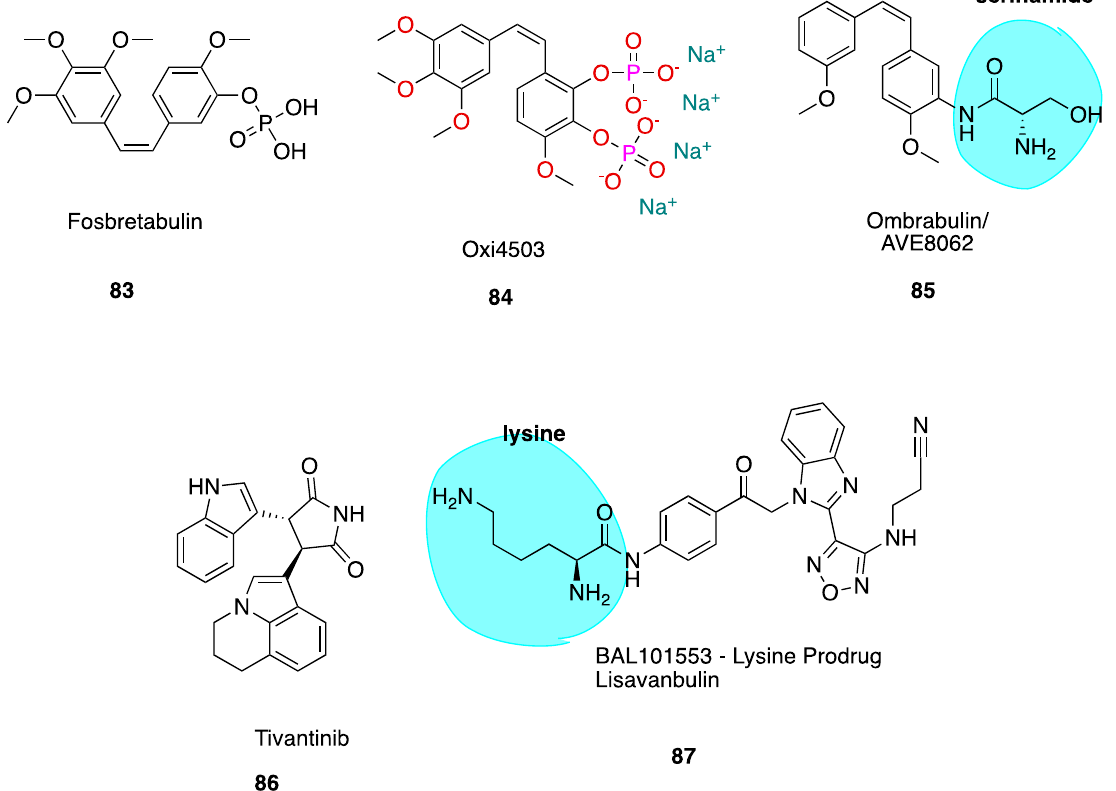
Figure 13. Structures of colchicine-binding site inhibitors in clinical trials.